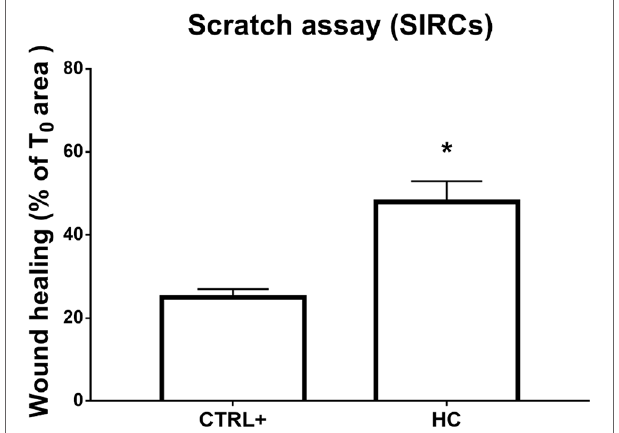
FIGURE 3 | Wound healing in SIRCs monolayer. *p < 0.05 HC treatment vs. CTRL+ (SIRCs monolayer scratch); SIRCs, rabbit corneal epithelial cells; HC, hydrocortisone; n =